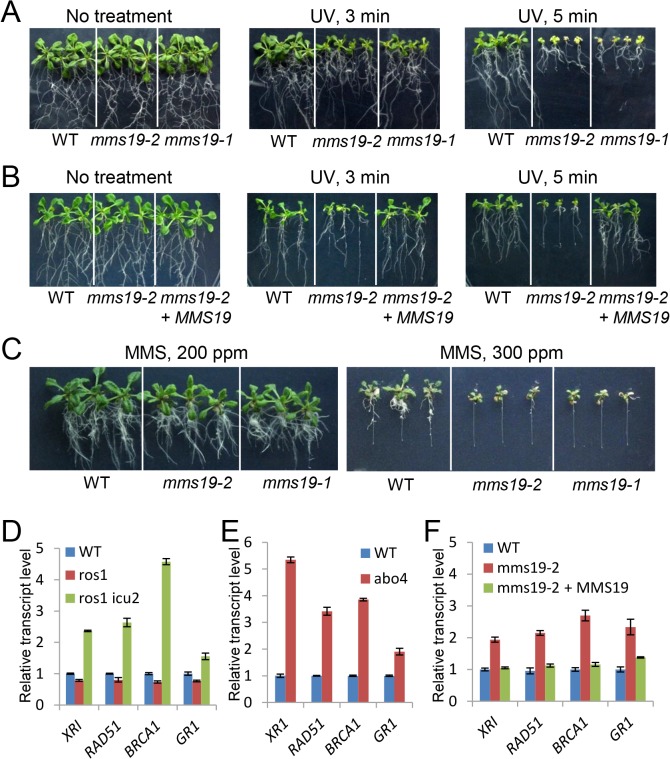
The mms19 mutants are sensitive to DNA damage and constitutively express a high level of DNA repair-related genes.(A) The mms19 mutants are more sensitive to UV-B treatment than the wild type. Five-day-old seedlings of the wild type and mms19 mutants were treated with UV-B light (1 kJ/m2) for different times and then grown with 16-h-light and 8-h-dark at 22° for 5–7 days before being photographed. (B) The sensitivity of the mms19-2 mutant to UV-B treatment was rescued by the MMS19-Myc transgene in T2 transgenic plants. (C) The mms19 mutants are more sensitive than the wild type to the DNA-damaging reagent methyl methanesulfonate (MMS). Quantitative RT-PCR results indicate that DNA repair-related genes were up-regulated in ros1icu2 (D), abo4 (E), and mms19 (F) mutants compared to their respective control plants. The seedlings were grown on MS medium plates for ~10 days under long-day-condition and then harvested for RNA isolation. Quantitative RT-PCR experiments were biologically repeated with similar results, and three technical replicates of one representative experiment were shown. Error bars represent the standard deviation (SD).